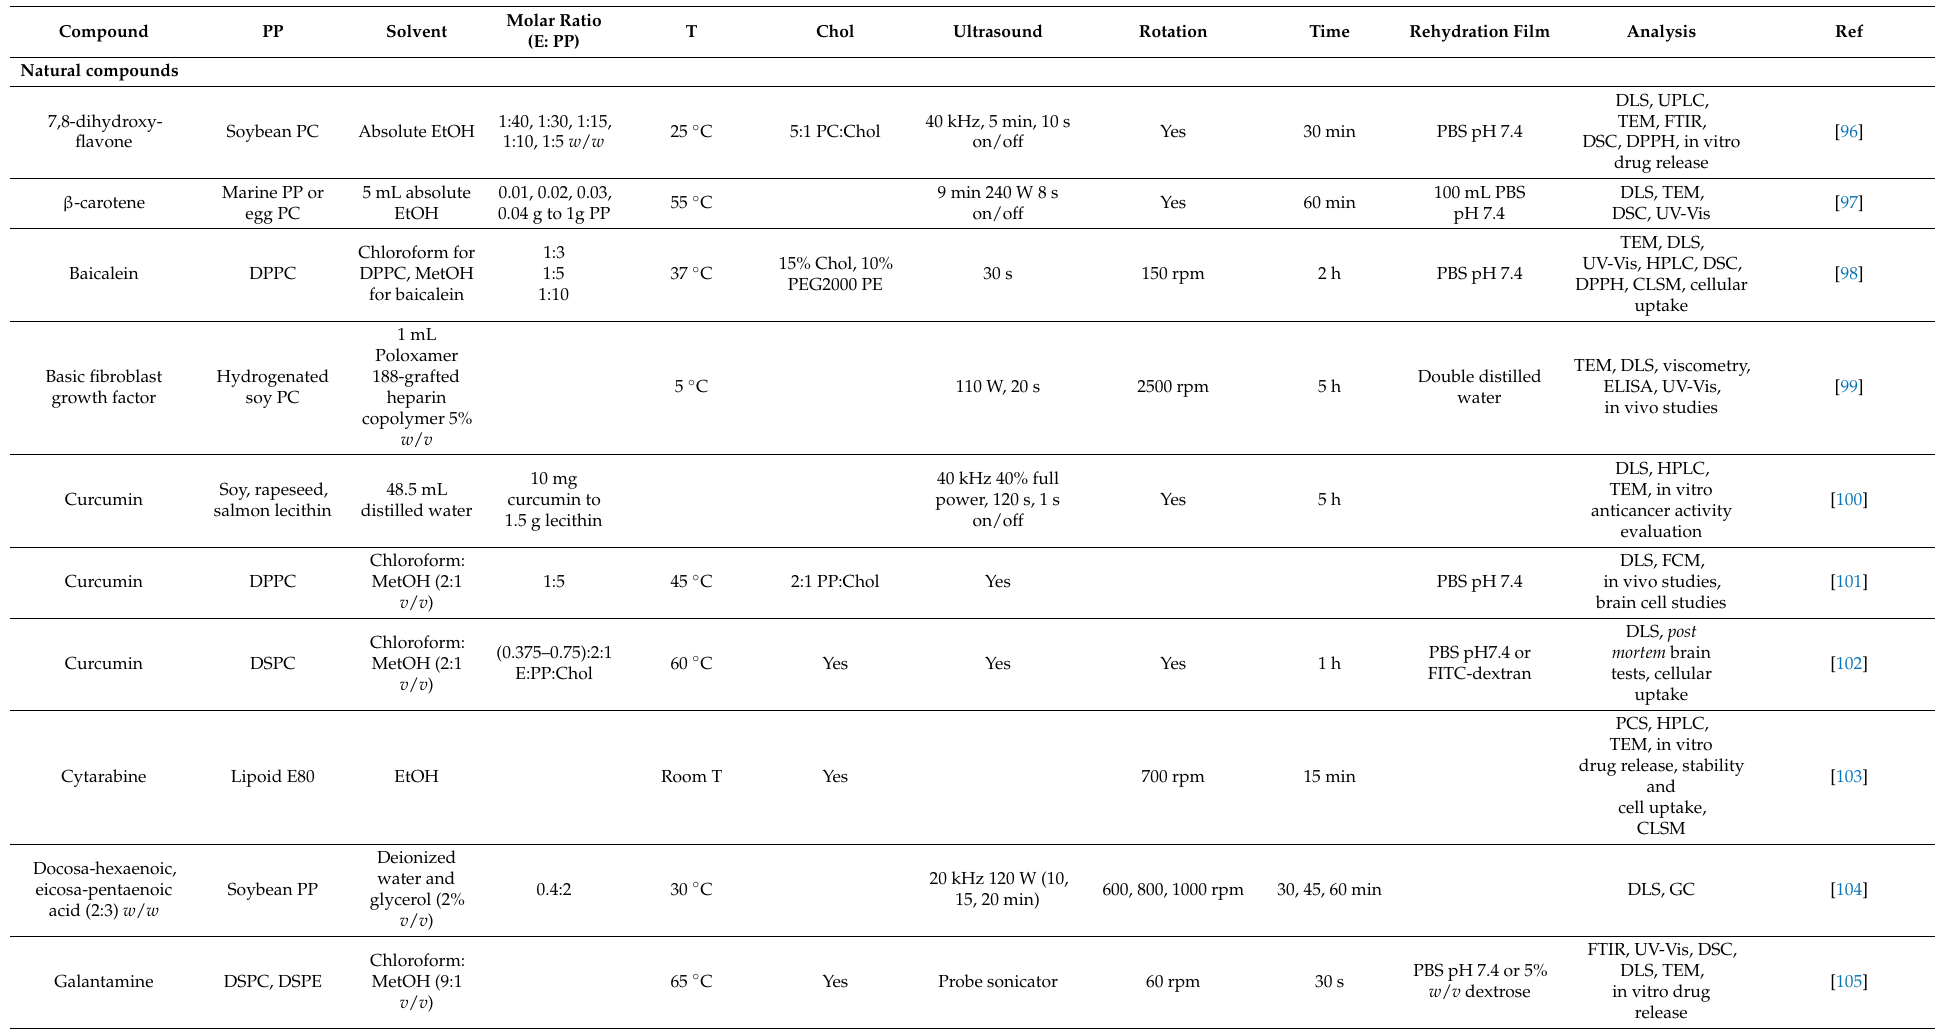
Table 2. Nanoliposomes produced to encapsulate neuroprotective